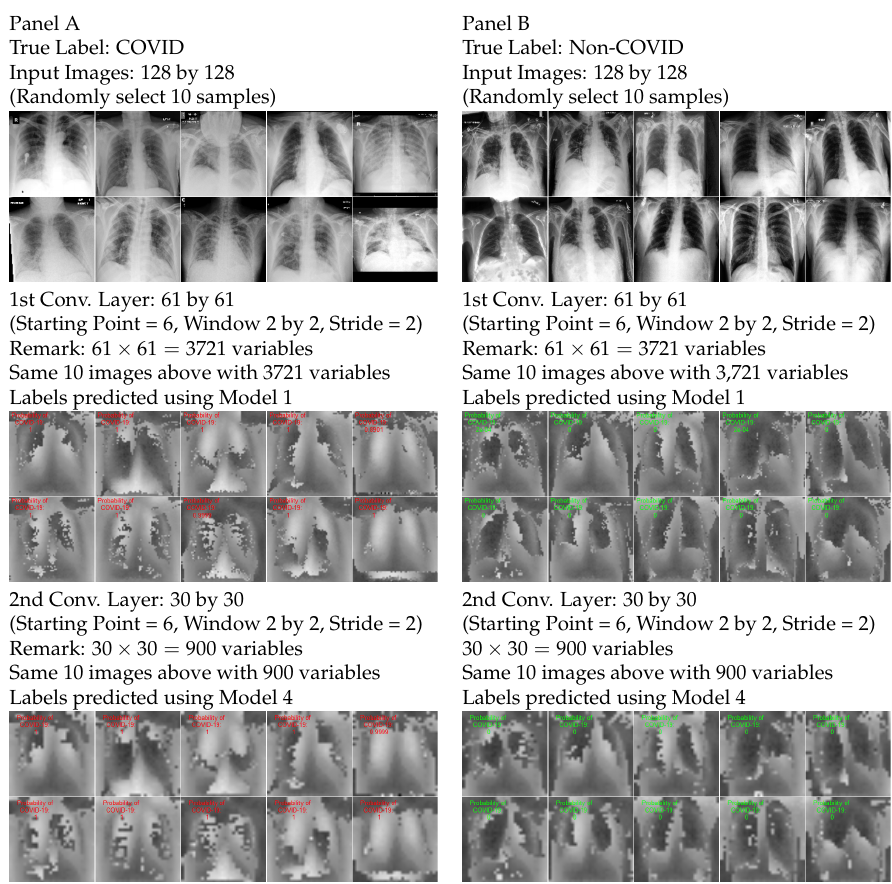
Figure 9. A summary of randomly sampled images from the COVID and non-COVID classes (10 each). Panel A represents COVID patients and panel B represents non-COVID individuals. The first row plots the original 128 by 128 images. The 1st Conv. Layer generates 61 61 = 3721 new × variables. We plot the same 10 images from both classes using these 3721 variables in the second row. We also provide the predicted COVID probabilities on top left corner of each image. The 2nd Conv. Layer generates 30 30 = 900 variables. We plot the same 10 images from both classes using these × 900 variables in the third row. We also provide the predicted COVID probabilities in the top left corner of each image assuming only these 900 variables are used as predictors. The plot of the original images for patients infected by COVID-19 has grey and cloudy textures in the chest area, which are due to inflammatory fluid produced when patients exhibit pneumonia-like symptoms. This shaded area (as seen in panel A ) prevents us from clearly observing the lungs. This is different in panel B , where the lung areas are dark and almost black, which means the lung is filled with air (i.e., normal cases). The black/white contrast in the two panels is directly related to the amount of much inflammatory fluid in human lungs, which translates to greyscale on pictures. The same contrast can be seen using the new variables (these are X † based on Equation (6)) in the 1st Conv. Layer (sized 61 by 61). For COVID-19 patients, the lung area is cloudy and unclear, whereas for the healthy cases, it is clearly